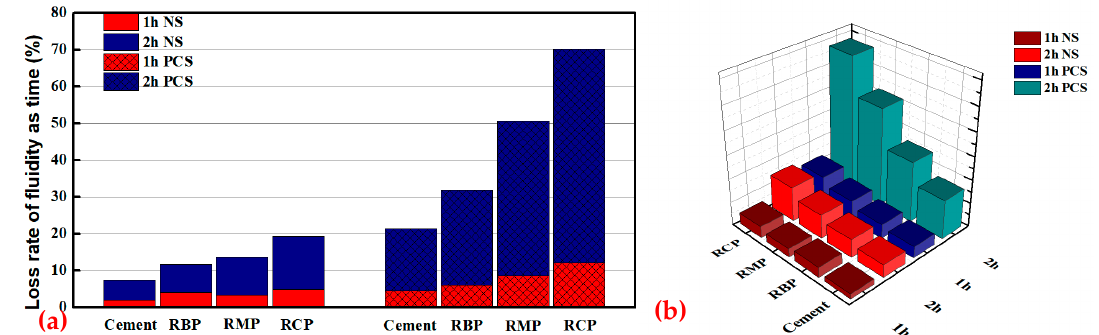
Figure 17. The LRFT of cement paste mixed with RP: ( a ) The columnar accumulation diagram of the LRFT, ( b ) The three-dimensional diagram of the LRFT.